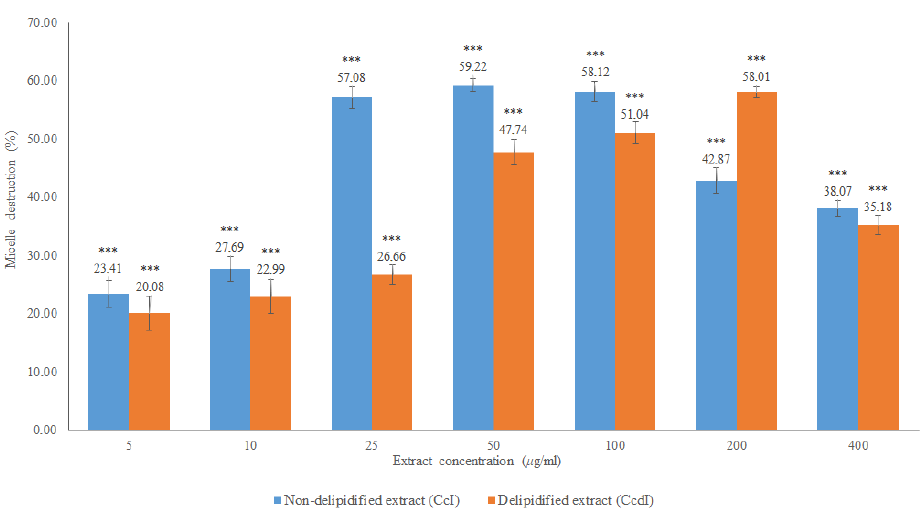
Figure 6. In vitro cholesterol micellar solubility assay of Cymbopogon citratus delipidified infusion (CcdI) and non-delipidified infusion (CcI). The results are expressed as the mean ± standard deviation (minimum of three independent assays, performed in triplicate). The control micelle destruction value was 100%. The statistical tests were performed with *** p < 0.05 compared to the control.